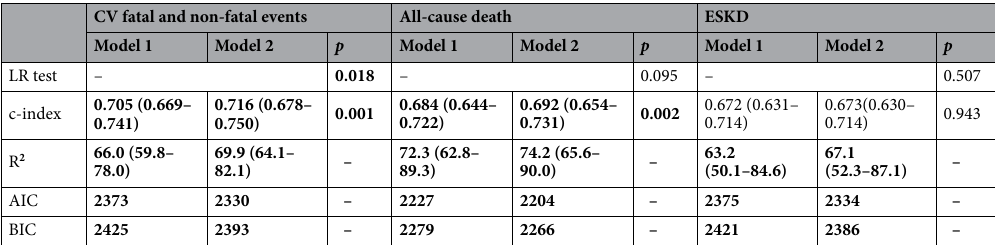
Table 4. Models performance and additional predictive value of smoking habit, when added to the fully adjusted Cox model, on the study endpoints. LR test (Likelihood Ratio test). Comparisons are made between Model 1 (without smoking habit) and Model 2 (including smoking habit). Model 1 and 2 were adjusted for all the covariates included in Table 3. AIC akaike information criterion, BIC Bayesian information criterion, R 2 Royston’s modification of Nagelkerke’s R 2 . Estimates with p value <0.05 are shown in bold.